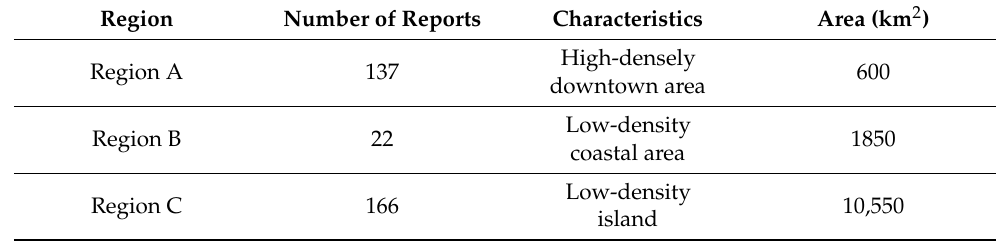
Table 1. Characteristics and number of inspection reports collected from different